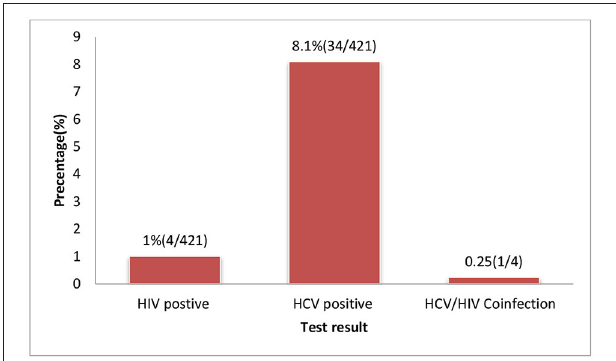
FIGURE 2 | HIV and HCV test result of pregnant women attending ANC services at selected health facilities East Wollega Administrative Zones, Oromia Regional State,